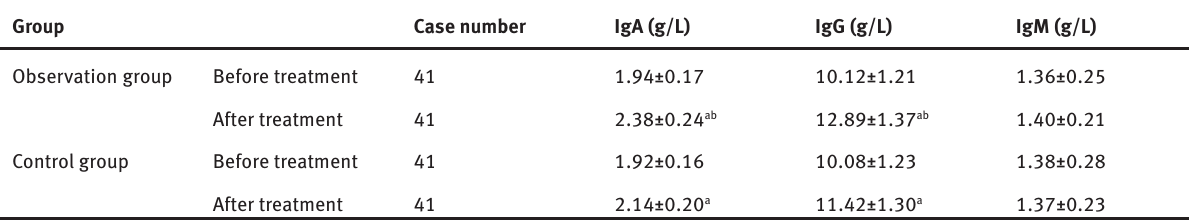
Table 5: Comparison of humoral immune function between two groups ( ±s)